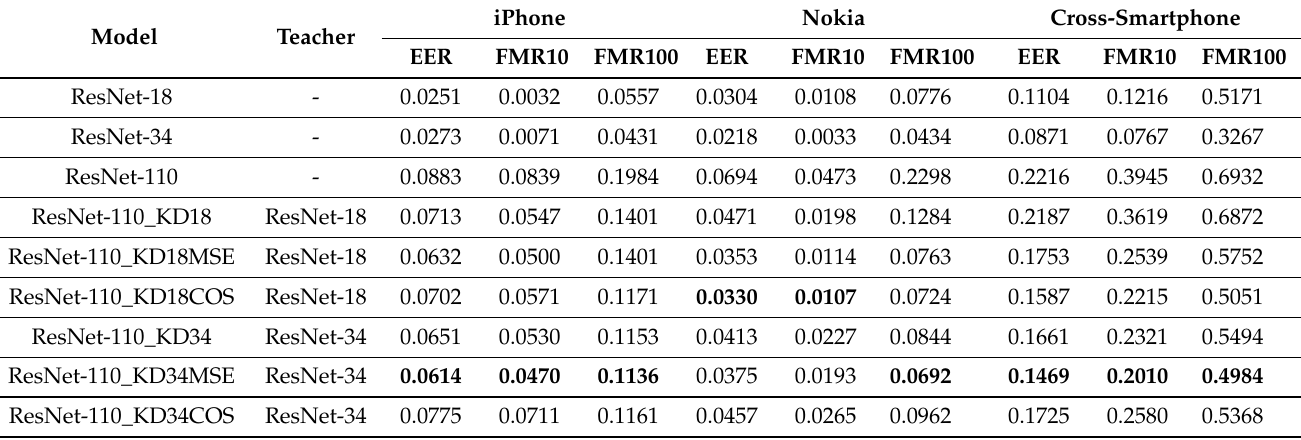
Figure 3. The achieved ROC curves for different experimental settings. For each experimental setting, the number next to the model label is the achieved AUC. Note the improvement in the ResNet-110 verification performance using our proposed template-driven KD approach. Table 2. Performance obtained for different experimental settings. The first three rows of the table present the achieved result for the three evaluated models (without using KD), where the smallest model (ResNet-100) performed the worst. The next three rows of the table present the achieved verification performance by including KD in the training process using ResNet-18 as a teacher with conventional KD loss, and both the template-driven KD with MSE and cosine (COS) embedding loss. The last three rows present the achieved KD verification performance using ResNet-34 as a teacher with conventional KD, and both the template-driven KD with MSE and cosine embedding loss. The enhanced performance by the proposed method in comparison to the conventional KD is illustrated over all experimental setups. The lowest EER, FMR10 and FMR100 for each of the verification scenarios (iPhone, Nokia and Cross-Smartphone) achieved by ResNet-100 are in